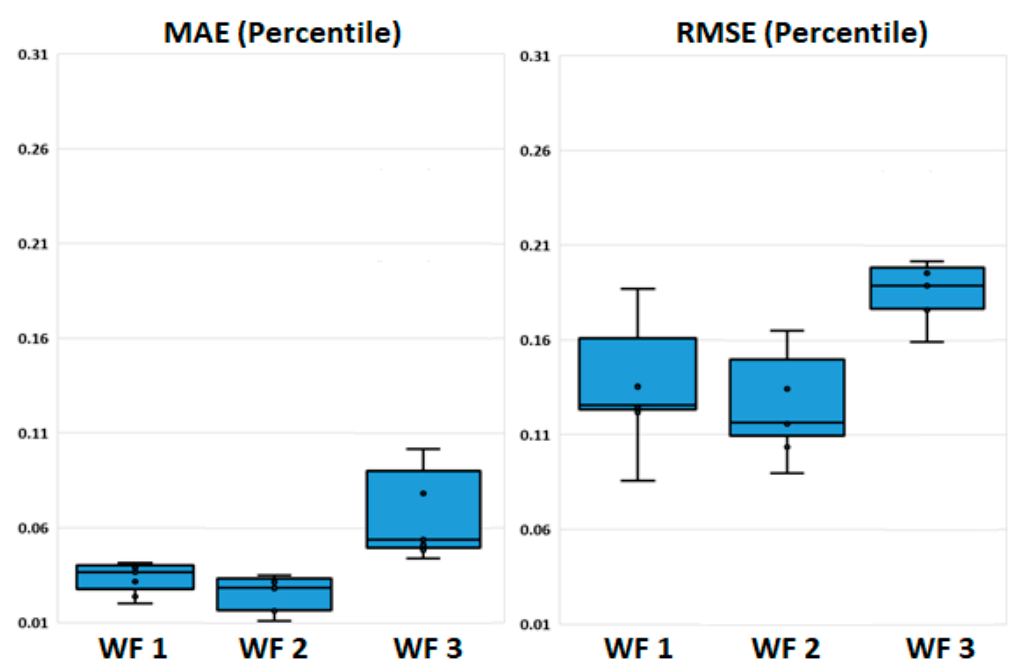
Figure 8. Distribution of MAE and RMSE Errors (Percentiles) for Windfarms “WF 1”, “WF 2” and “WF 3”.